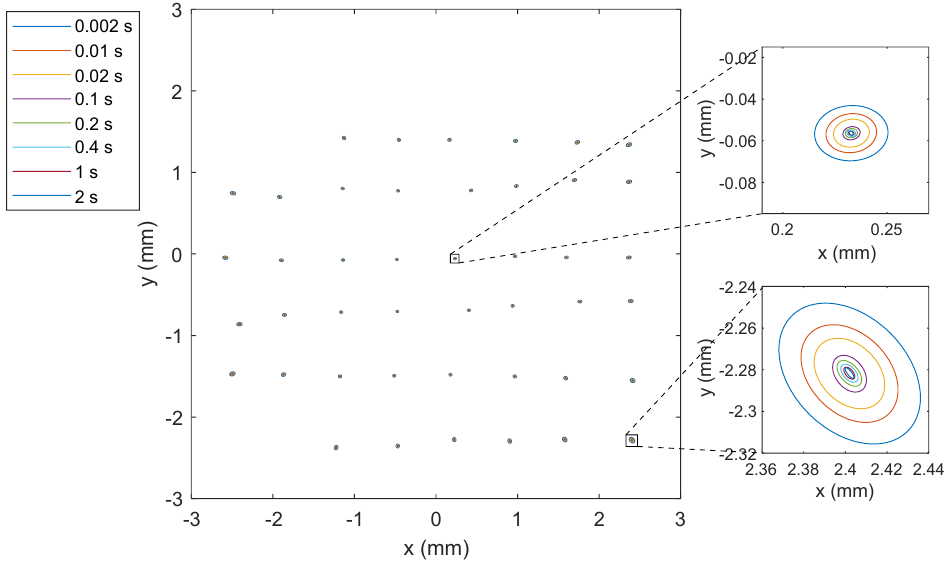
Figure 13. Error ellipsoids on the surface of the PSD as a function of measurement